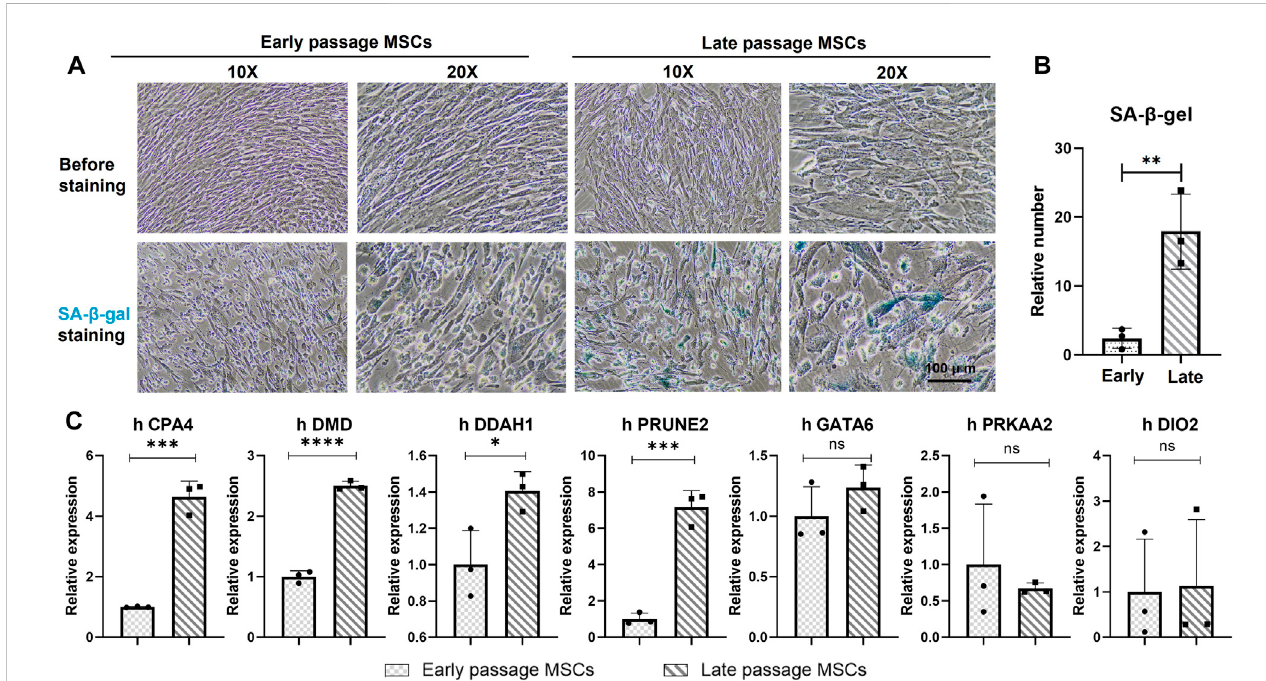
FIGURE 5 Validation of seven genes in early and late passages of MSCs. (A) Morphologies and the SA- β -Gal staining of early passage (P3) and late passage (P12) MSCs. Scale bar = 100 μ m. Cells with blue dye inside of the cell plasma indicated as senescence cells (SA- β -Gal + ). (B) Quantitively analysis of the SA- β - Gal + cellsinearlypassagesandlatepassagesMSCs. Dataweregeneratedfromcountingofpositivenumbersfromthreeindependenceexperiments. (C) qPCR veri fi cationof theseven genes, CPA4, DMD,PRKAA2,DDAH1,DIO2, GATA6 and PRUNE2 inearly passage (P3) andlate passage(P10 and P12) MSCs. * p < 0.05; ** p < 0.01; ns: non-signi fi cant. N =